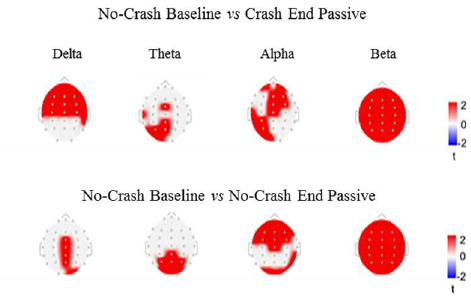
Fig 6. Statistically significant differences between power spectrum density in the comparison between No Crash Baseline vs Crash End Passive and No Crash Baseline vs No Crash Passive in the bands: Delta (2-4Hz), Theta (5-7Hz), Alpha (8-12Hz), Beta